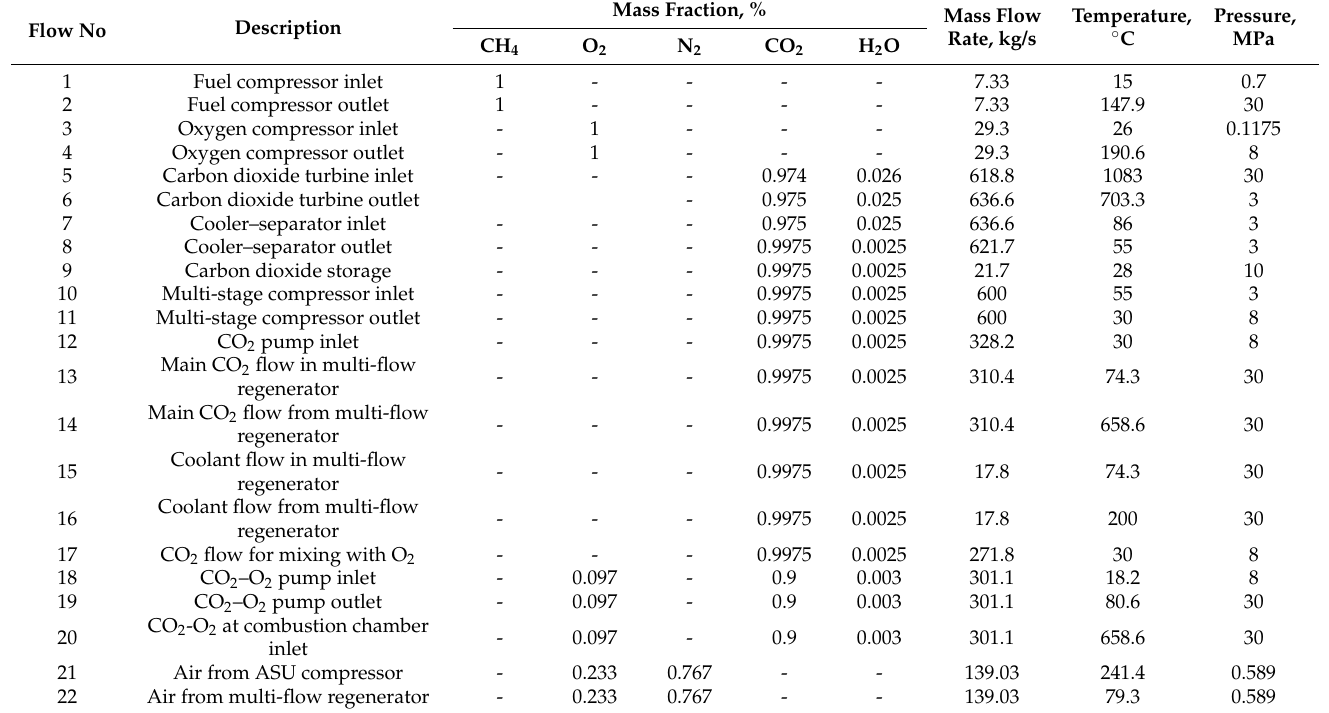
Figure 3. Simulation flowchart. Table 3. Simulation flow parameters.